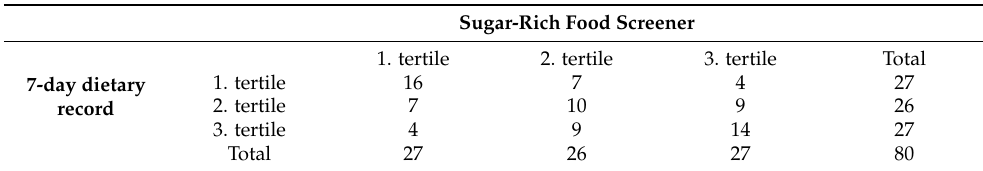
Table 3. Cross-classification between intake of discretionary foods and drinks (portions of 450 kJ/week) estimated by the SRFS and the 7-day dietary record ( n = 80).